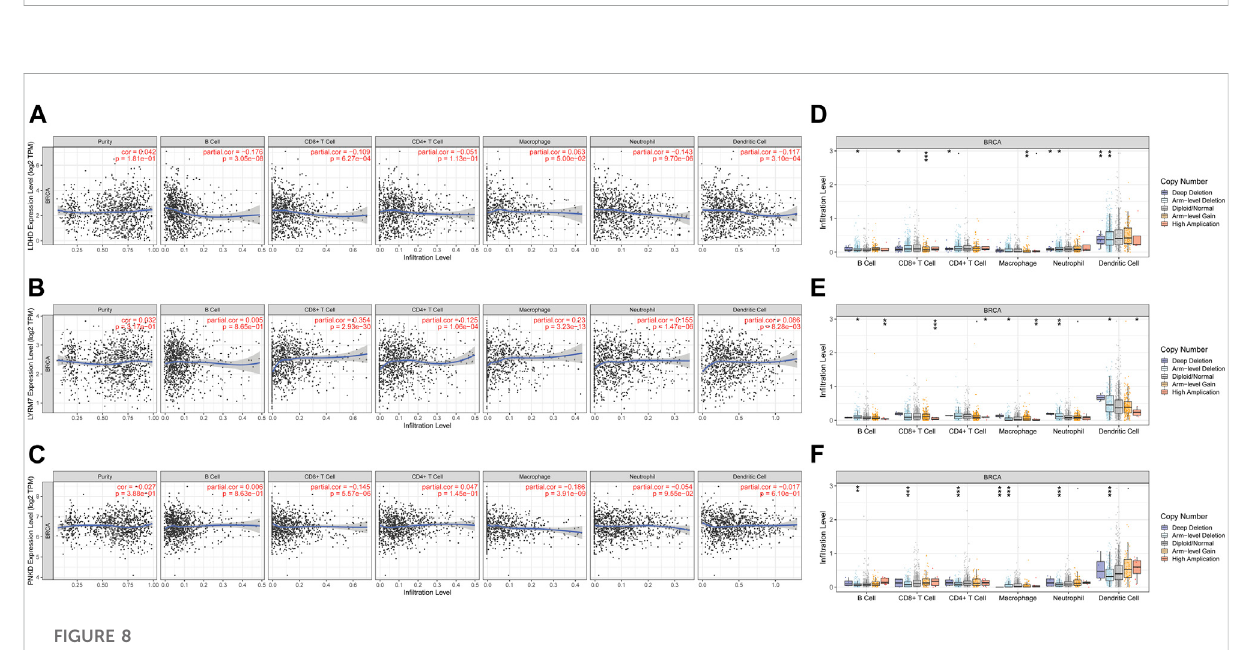
FIGURE 8 Association between three prognostic genes and immune in fi ltration in BC. The association between the immune cells and the expression of LDHD (A) , LYRM7 (B) , and PNKD (C) . Relationship between the mutants of three model-related genes and immune cell in fi ltration LDHD (D) , LYRM7 (E) , and PNKD (F) . * p < 0.05, ** p < 0.01, and *** p <